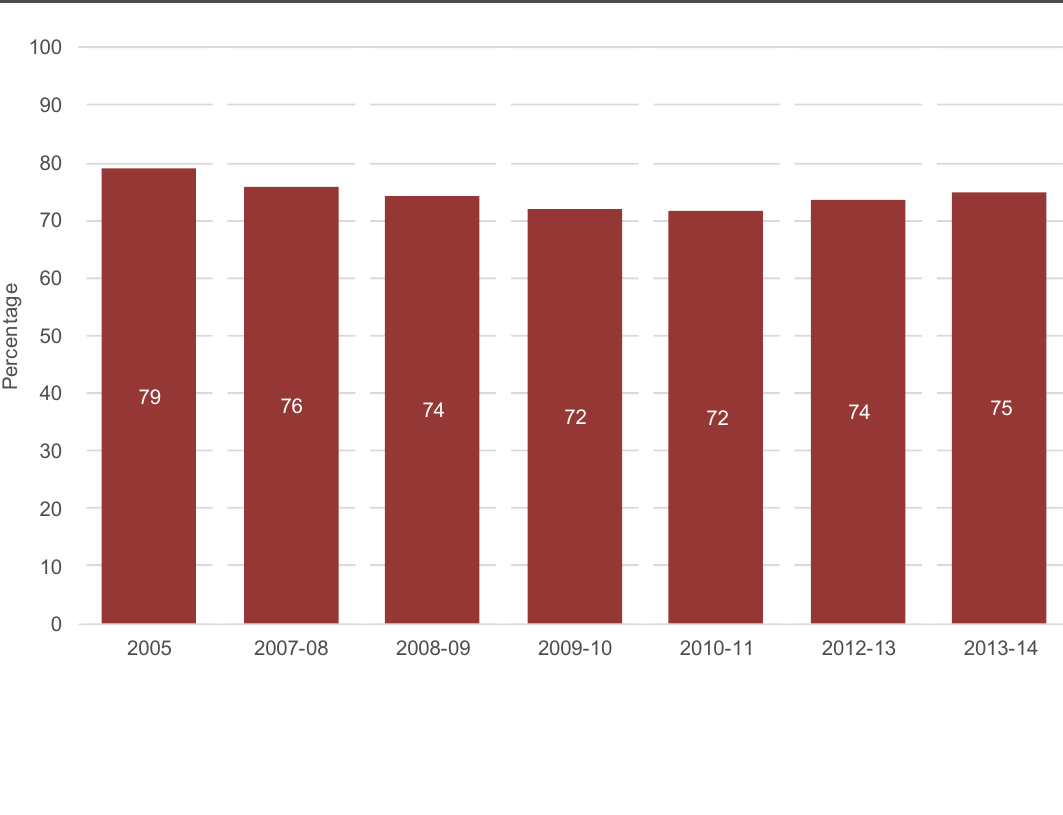
- Table 5: Charitable giving by sex, age and ethnicity, 2005 to 2013-2014